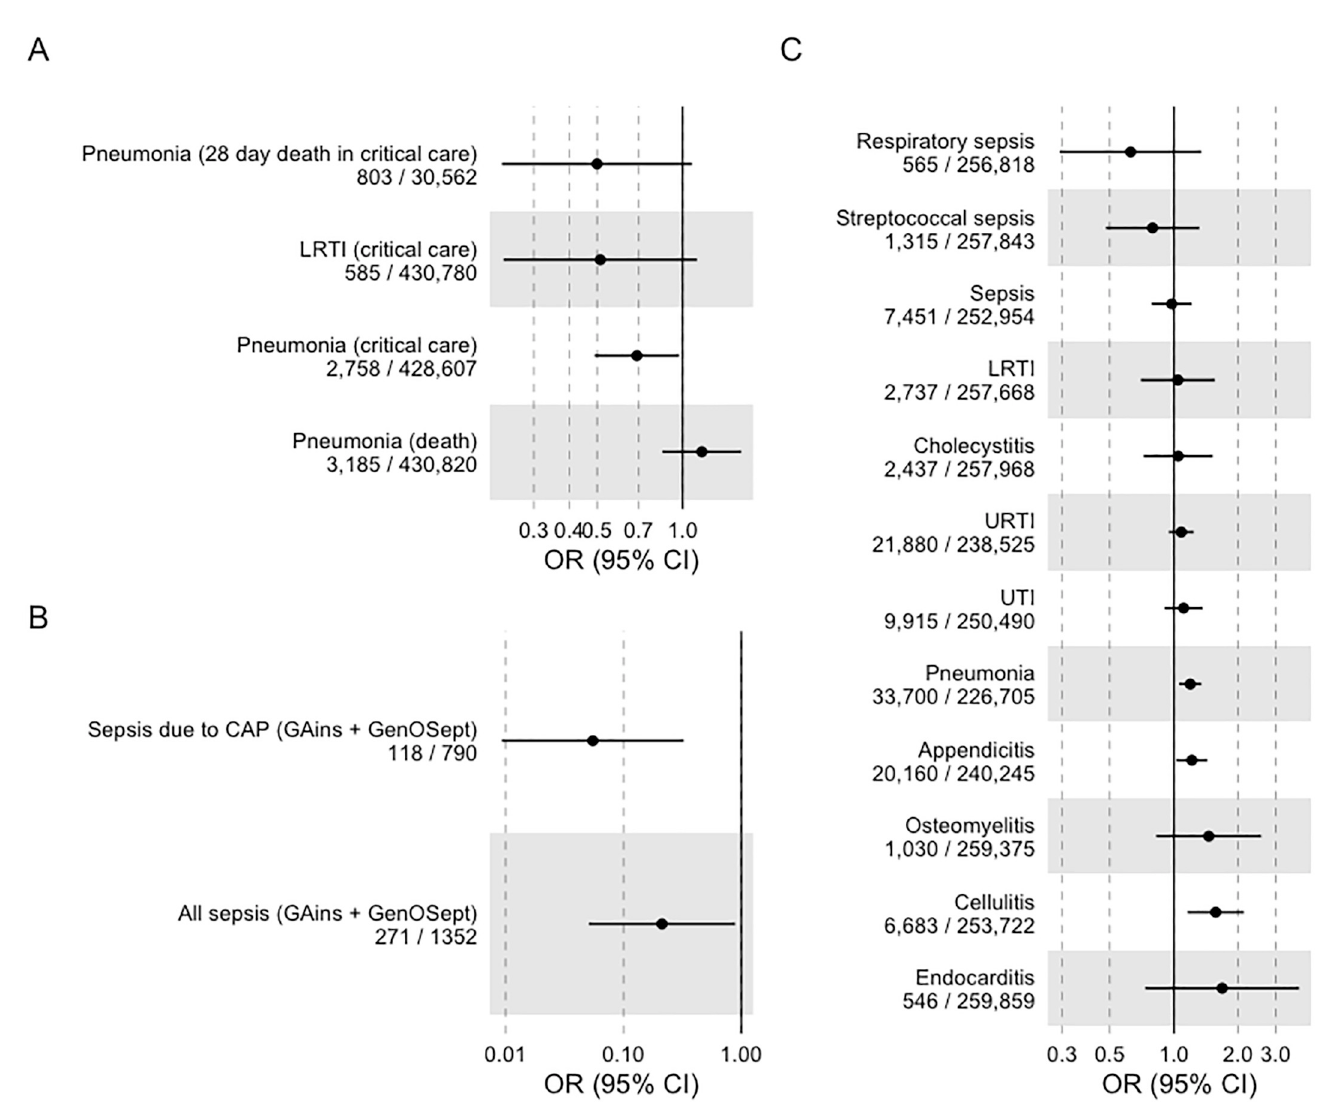
Fig 3. IVW MR estimates of IL6R blockade with 95% CIs for (A) respiratory infection, (B) survival from sepsis related to critical care admission, and (C) FinnGen replication cohort. CI, confidence interval; IVW, inverse variance weighted; LRTI, lower respiratory tract infection; MR, Mendelian randomisation; OR, odds ratio; URTI, upper respiratory tract infection; UTI, urinary tract